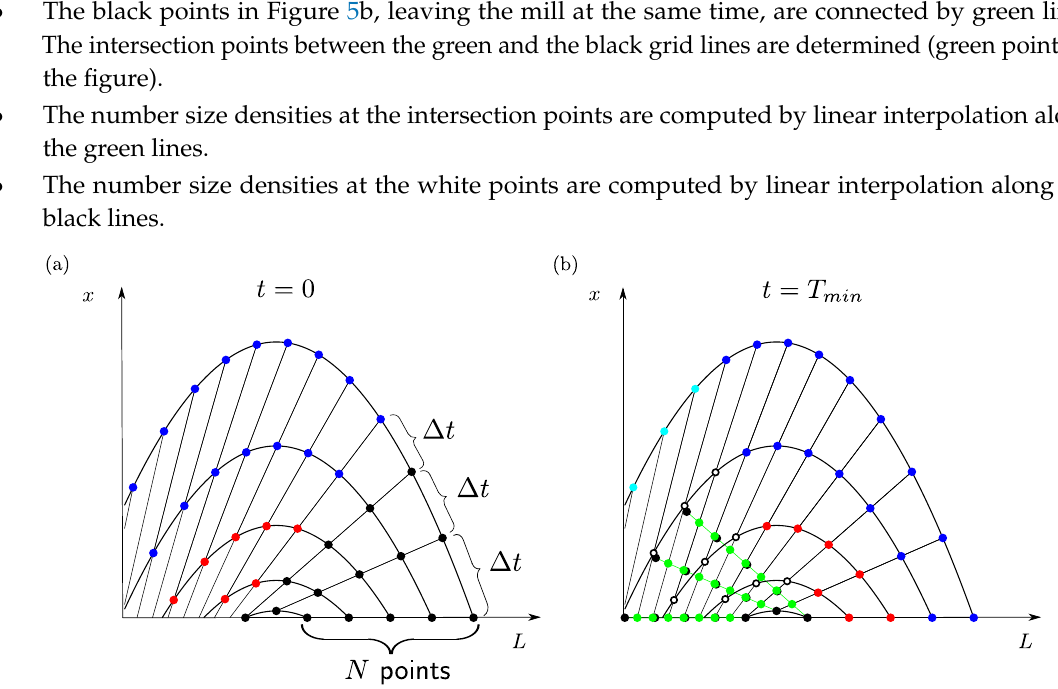
Figure 5. Grid points for the numerical solution of the linear model. Left diagram ( a ): grid points at t = 0 as intersections between characteristic curves and straight lines connecting crystals with identical temporal distance from the mill. Right diagram ( b ): blue and red points show where the crystals at the blue and red points in diagram ( a ) have moved at t = T min without reaching the mill; black points show where the crystals at the black points in diagram ( a ) have moved at t = T min after passing the mill; the number size densities at the black points are calculated from (4); green points are intersections between black lines (original grid lines) and green lines (resulting from the black lines after passing the mill); the number size densities at the white points are calculated by linear interpolation from the green points; number size densities at the light blue points are calculated directly from the boundary condition